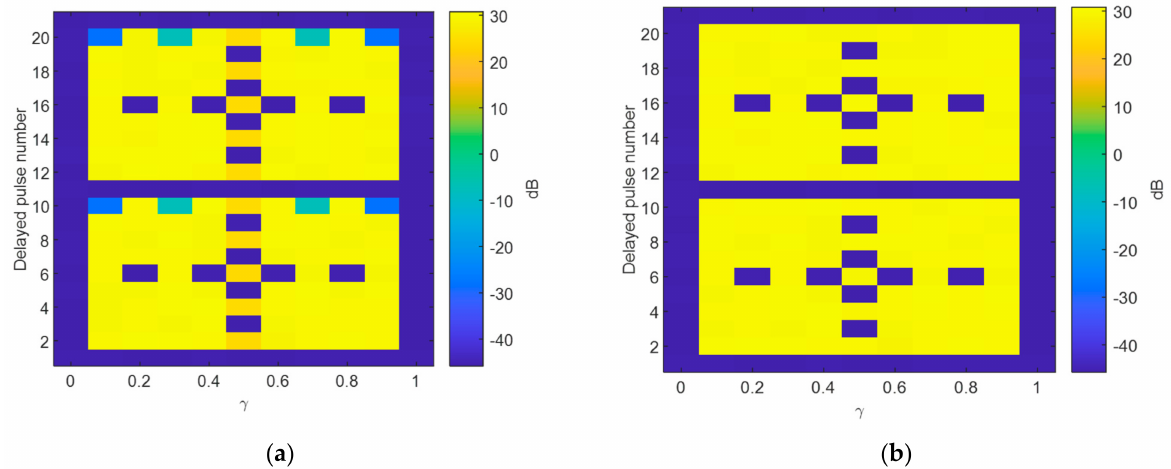
Figure 10. Anti-jamming performance, with respect to frequency increment and delayed pulse number. ( a ) Non-adaptive beamforming and ( b ) adaptive